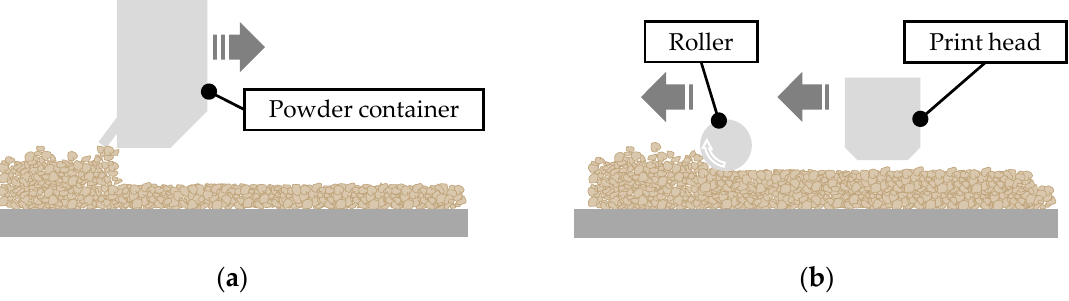
Figure 3. Schematic illustration of the recoating ( a ) and printing process ( b ).